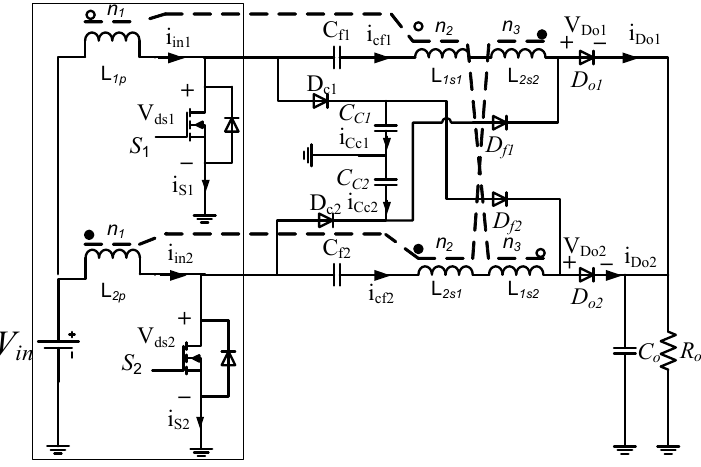
Figure 1. Interleaved high step-up current sharing converter with coupled conductors.